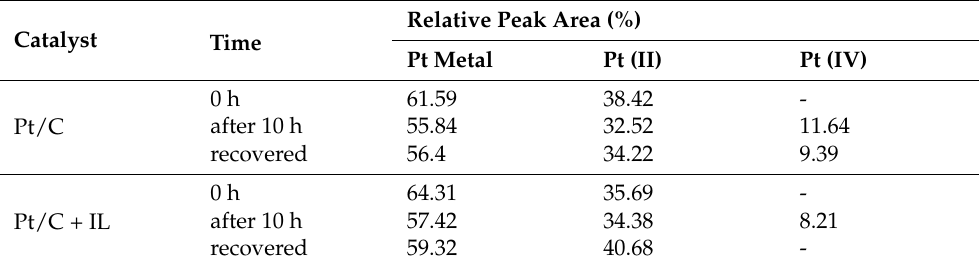
Figure 6. The Pt 4f XPS spectra for Pt/C before durability test ( a ), after durability test ( b ), and after CV recovery ( c ); for Pt/C + IL before durability test ( d ), after durability test ( e ), and after CV recovery ( f ). Table 1. The relative peak areas of Pt and Pt + IL.